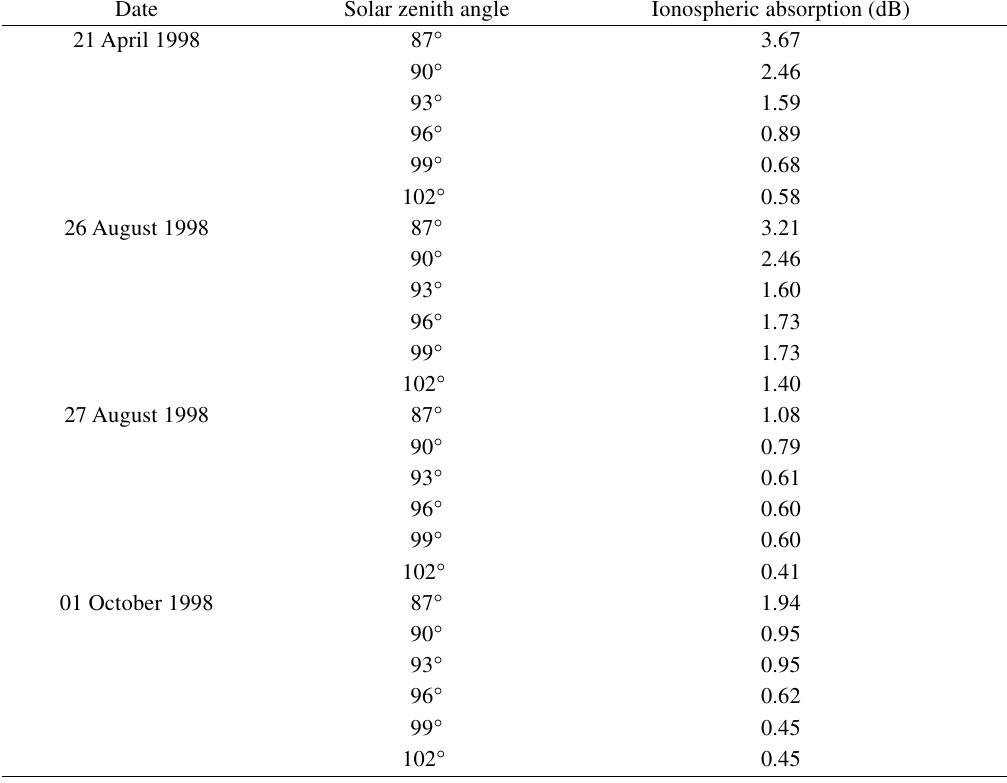
Table I. Hourly ionospheric absorption data as function of the solar zenith angles between 87 ° and 102 ° ; the days where the solar proton flux affects the ionospheric absorption more than the magnetic storm were